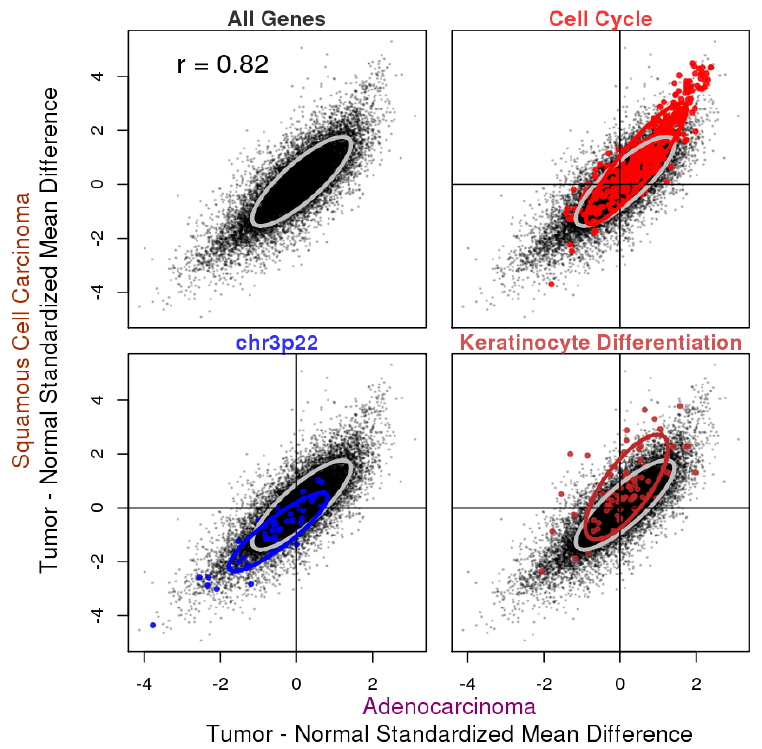
Figure 2. Tumor: the normal standardized mean expression difference in ADC and SQCC with selected genes highlighted. Summary tumor: the normal standardized mean difference from the meta-analysis was plotted for all genes, with results from ADC on the x-axis and results from SQCC on the y-axis. The Pearson correlation coefficient for all genes was 0.82. Genes from three selected gene sets were highlighted: the cell cycle gene set from REACTOME_CELL_CYCLE in c2.cp curated the canonical pathway gene sets collection, chr3p22 genes were from the c1 positional gene sets collection and keratinocyte differentiation genes were from GO_KERATINOCYTE_DIFFERENTIATION in the c5.bp GO biological process gene sets collection in MSigDB. Note that the majority of cell cycle genes were upregulated and the majority of chr3p22 genes were downregulated in the tumors of both histological subtypes, whereas the keratinocyte differentiation genes were specifically upregulated in the SQCC tumors. Ellipsoidal boundary wrapped around the 75% highest density/minimum volume for all genes (gray) or selected genes (non-gray colors).